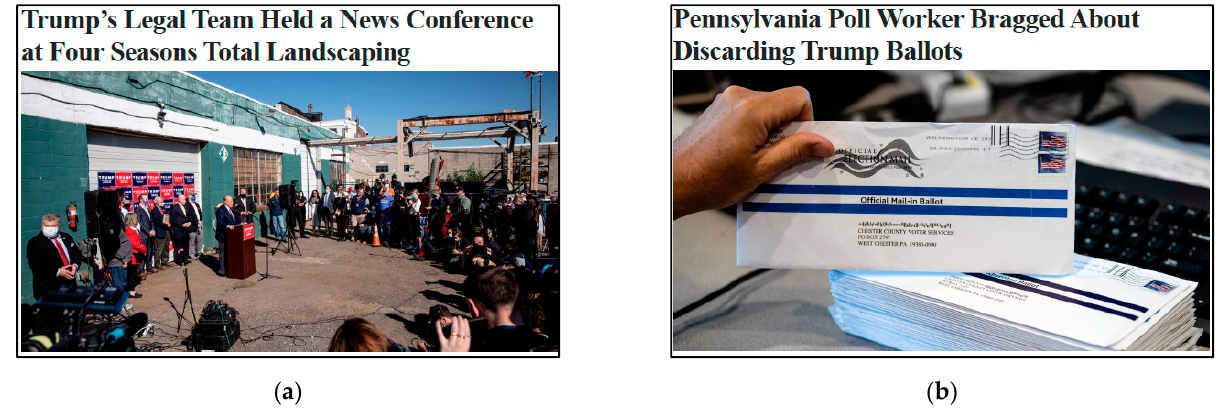
Figure 1. Example of true ( a ) and false ( b ) headlines as they appeared to participants.